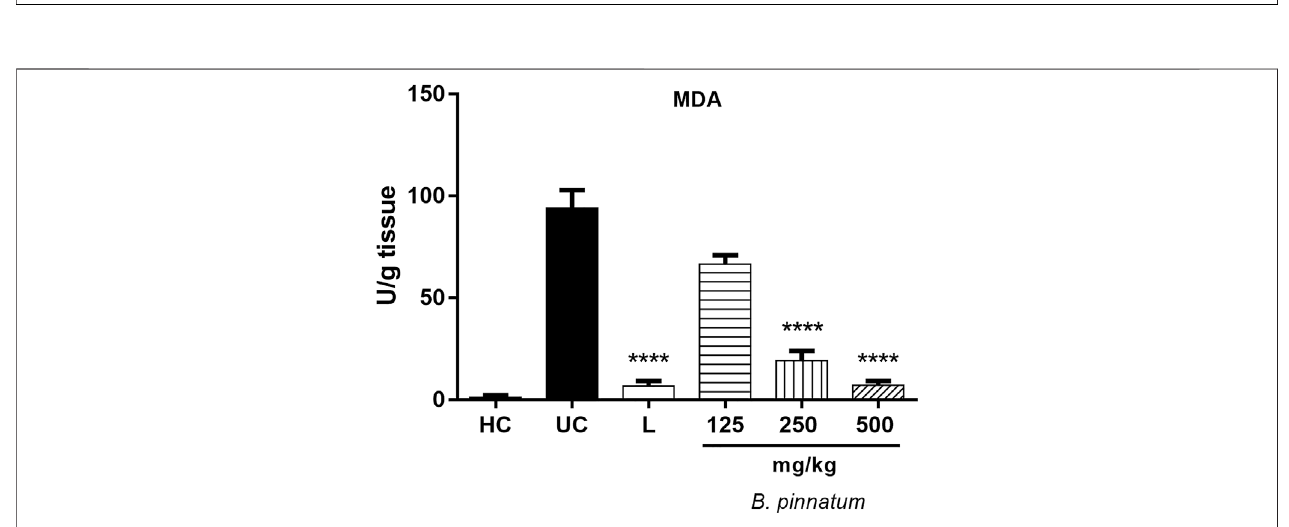
FIGURE5| Effectoftreatmentwith B.pinnatum leafextract(125,250,and500 mg/kg)onMDAlevelsintheaceticacid – inducedchronicgastriculcermodelinrats. Results expressed as mean ± standard mean error ( n (cid:2) 6). ANOVA and Tukey post-test were used to calculate the statistical signi fi cance, **** p < 0.0001 vs. ulcerated control. Healthy control, HC; ulcerated control, UC; lansoprazole (30 mg/kg), L.